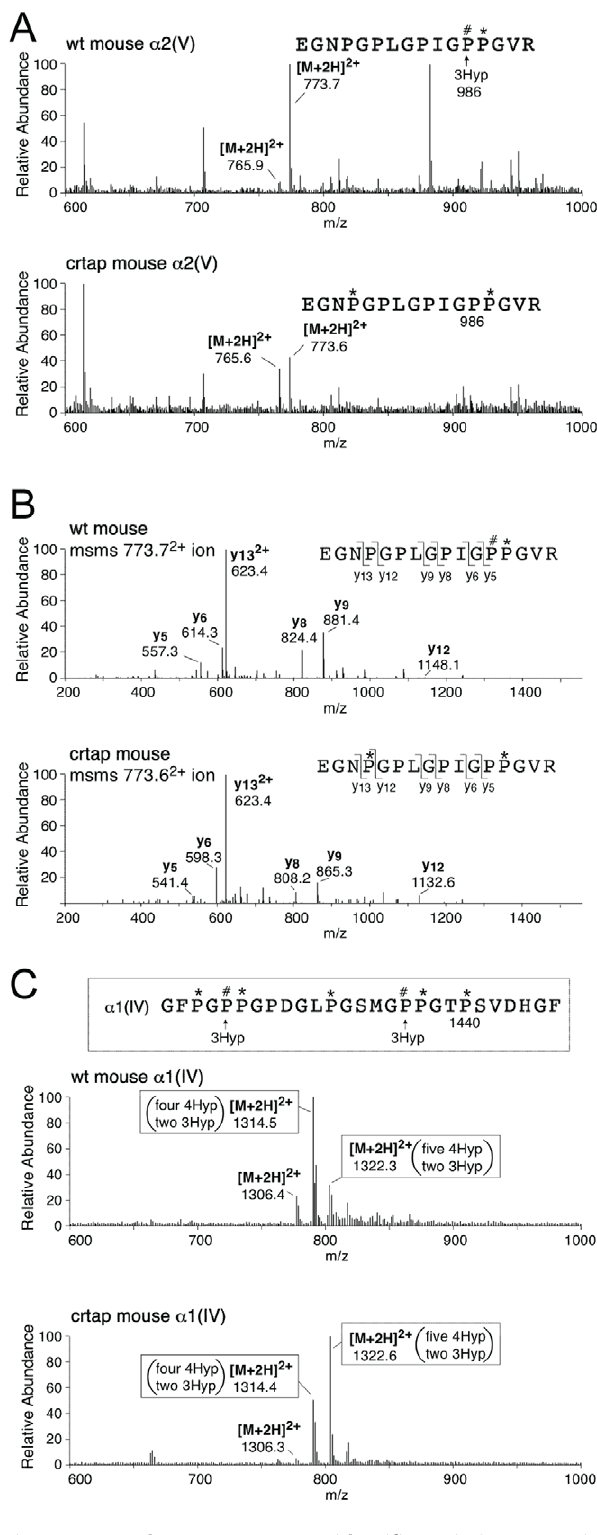
Figure 5. Tandem mass spectra identifies missing 3Hyp in Crtap-/- mouse at a 2(V) P986. ( A ) Full scan spectra over the LC elution window of the tryptic peptide containing P986 from wildtype and Crtap-/- a 2(V) from bone. ( B ) MS/MS spectra that identify the main forms of the variably hydroxylated peptides. From wildtype, P986 is almost fully 3-hydroxylated and the earlier P at 978 is